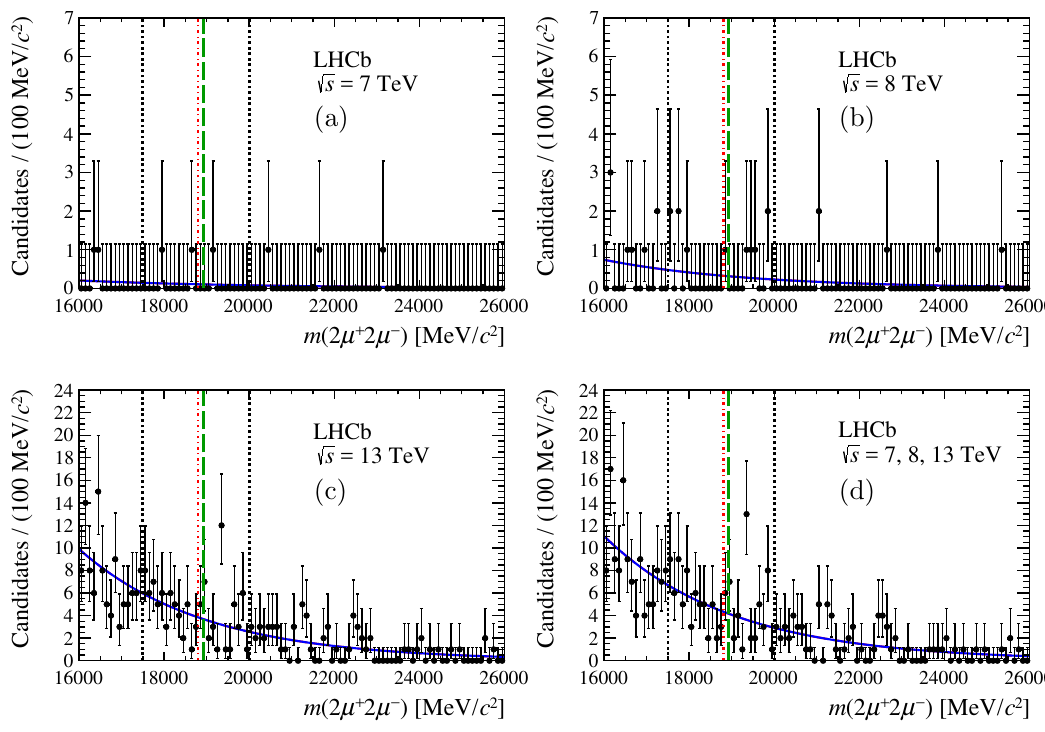
Figure 3 . Distributions of m (2 (cid:22) + 2 (cid:22) (cid:0) ) for the signal datasets at pp centre-of-mass energies of (a) 7 TeV, (b) 8 TeV, (c) 13 TeV and (d) all combined, using a bin size comparable to the expected X mass resolution. In each case the region around the corresponding (cid:7) (1 S ) peak has been selected. The background-only (cid:12)t function (solid blue line) is shown overlaid. The dotted black lines indicate the range in which limits are set on the product of the X production cross-section and branching fractions. The dash-dotted red and long-dashed green lines show the positions of the (cid:17) b (cid:17) b and (cid:7) (1 S ) (cid:7) (1 S ) thresholds,